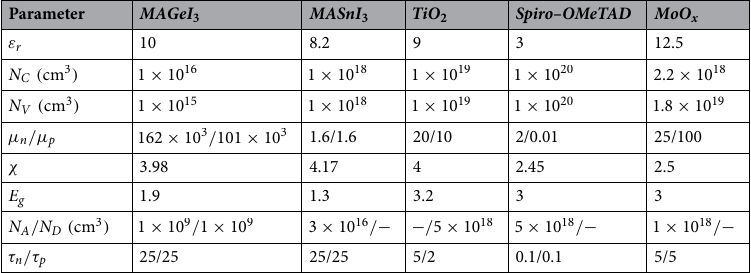
Table 2. The electrical parameters of the modeled